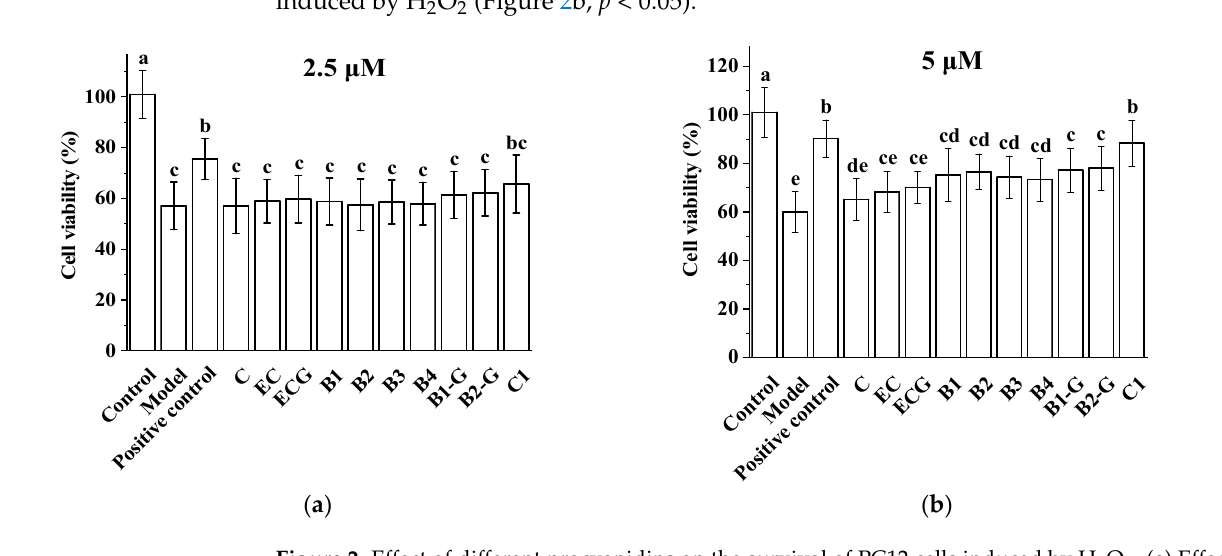
Figure 2. Effect of different procyanidins on the survival of PC12 cells induced by H 2 O 2 . ( a ) Effect of 2.5 μ M procyanidins on the survival of PC12 cells induced by H 2 O 2 ; ( b ) Effect of 5 μ M procyanidins on the survival of PC12 cells induced by H 2 O 2 . Control, Blank control group; Model. H 2 O 2 (200 μ M); Positive control, NAC (20 μ M) + H 2 O 2 (200 μ M); C, C + H 2 O 2 (200 μ M); EC, EC + H 2 O 2 (200 μ M); ECG, ECG + H 2 O 2 (200 μ M); B1, B1 + H 2 O 2 (200 μ M); B2, B2 + H 2 O 2 (200 μ M); B3, B3 + H 2 O 2 (200 μ M); B4, B4 + H 2 O 2 (200 μ M); B1-G, B1-G + H 2 O 2 (200 μ M); B2-G, B2-G + H 2 O 2 (200 μ M); C1, C1 + H 2 O 2 (200 μ M). Data are expressed as the mean ± SD. All experiments were conducted six times. Values with different letters above each bar represent significant differences ( p < 0.05, one-way ANOVA). NAC, N-acetyl-L-cysteine.